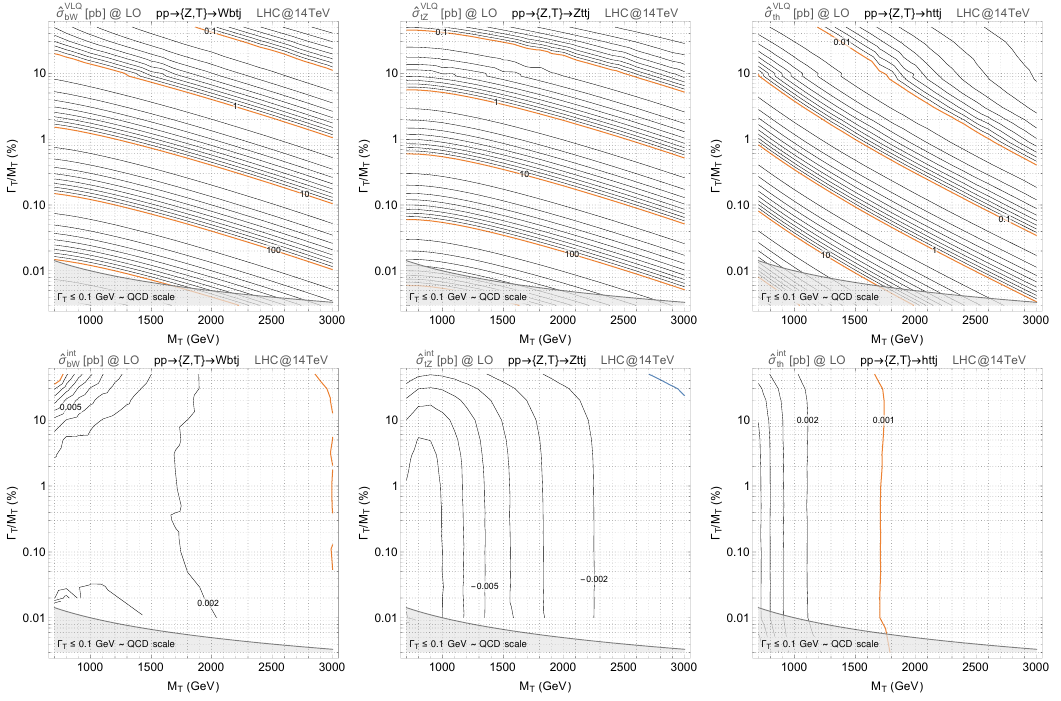
Figure 27 . Same as figure 26, but for proton-proton collisions at 14 TeV